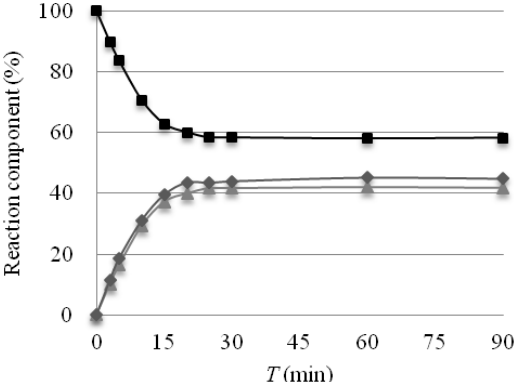
CHCH CHTf ( 5 ); diamonds, Tf 2 2 2